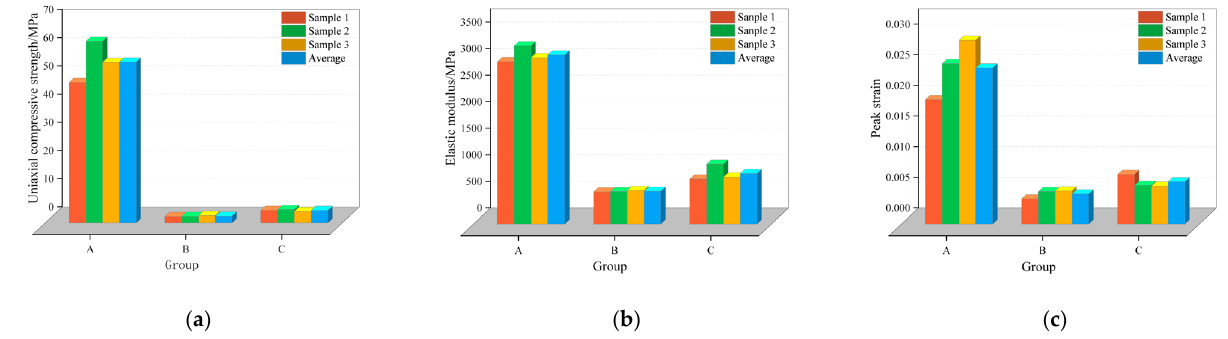
Figure 6. Comparison of uniaxial compressive strength, elastic modulus, and peak strain. ( a ) Uniaxial compressive strength; ( b ) elastic modulus; ( c ) peak strain.